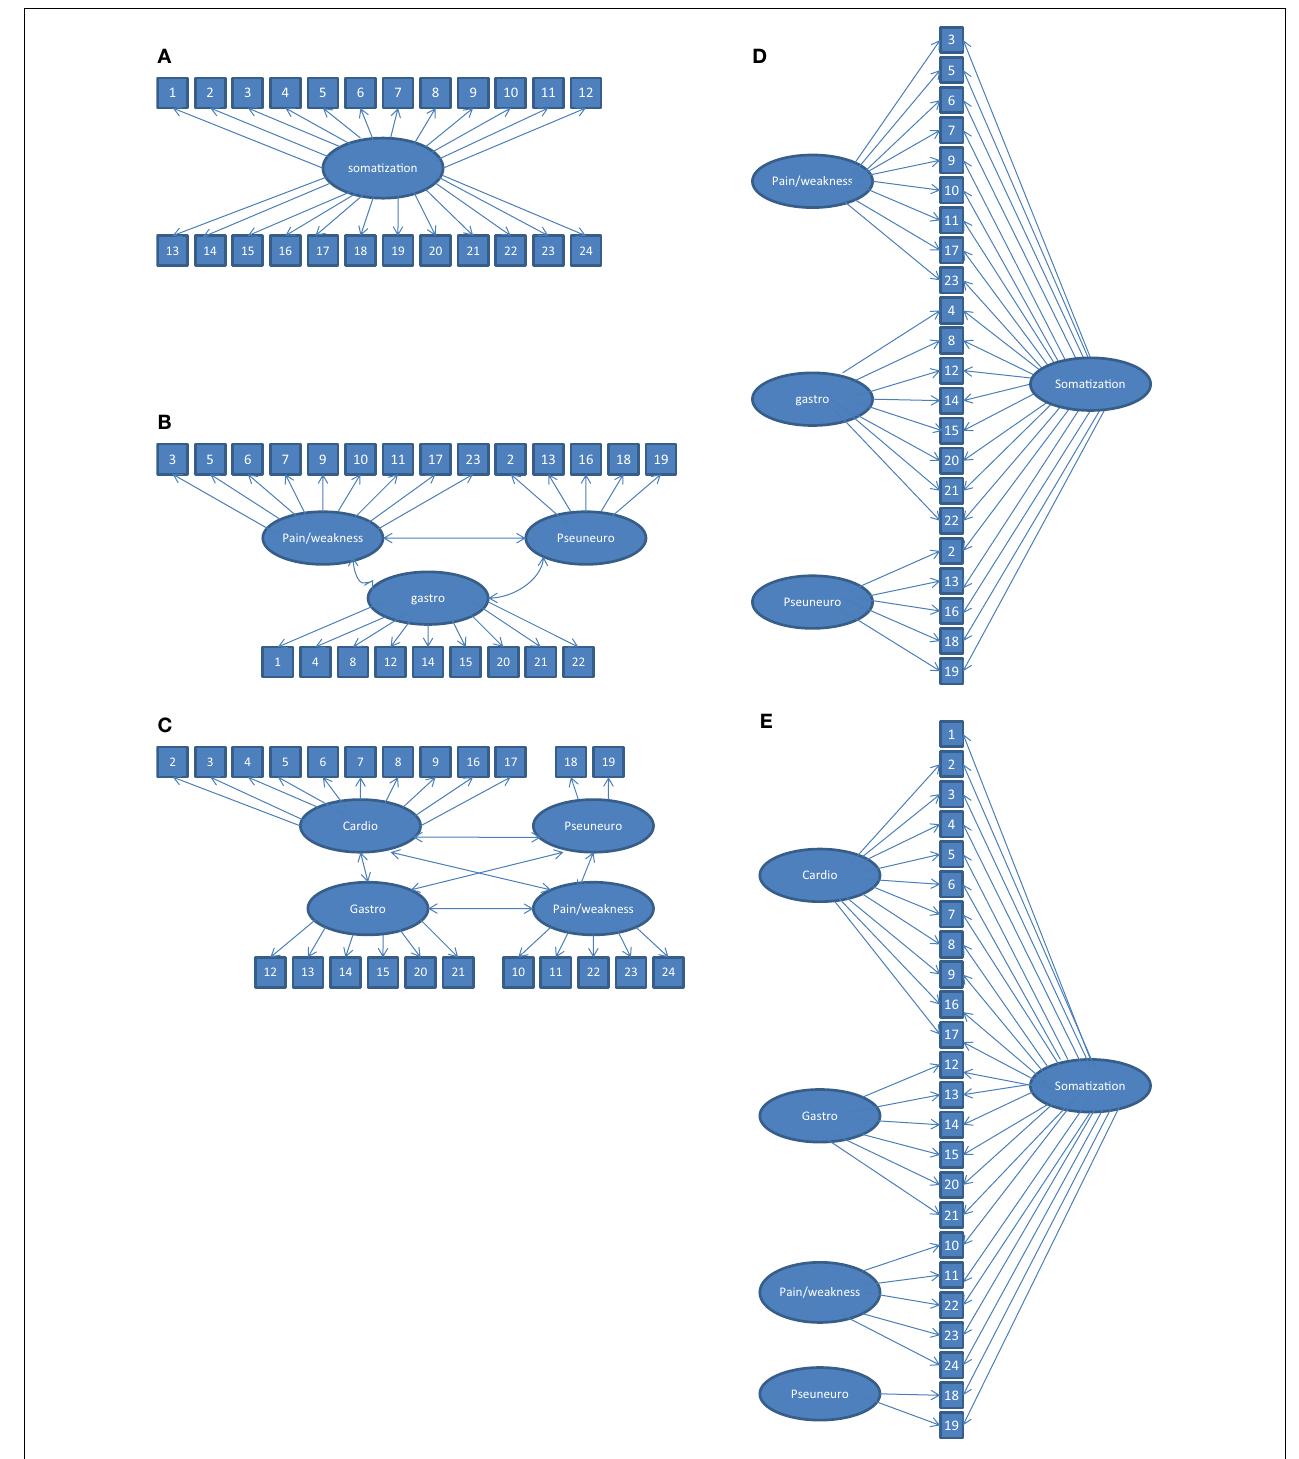
(somatization) and three specific factors (pain/weakness, gastrointestinal problems, and pseudoneurological problems). (E) bifactor model with one general factor (somatization) and four factors (Pain/weakness, cardiovascular problems, gastrointestinal problems, and pseudoneurological problems).This model included item 1 (“headaches”) as being part of the general